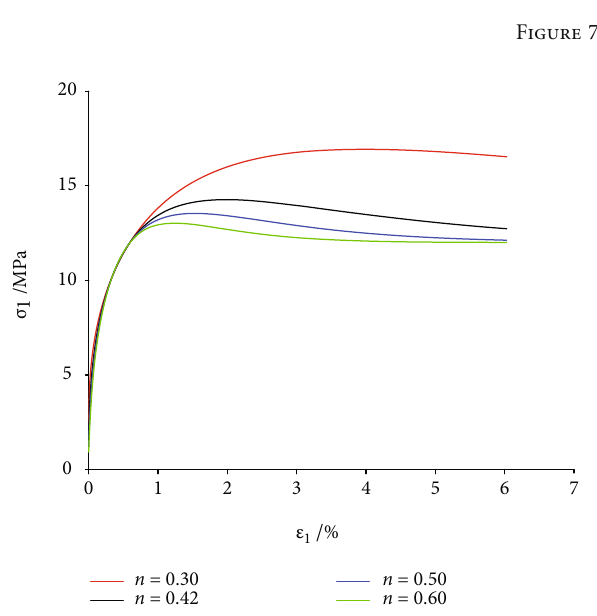
Figure 7: E ff ect of F